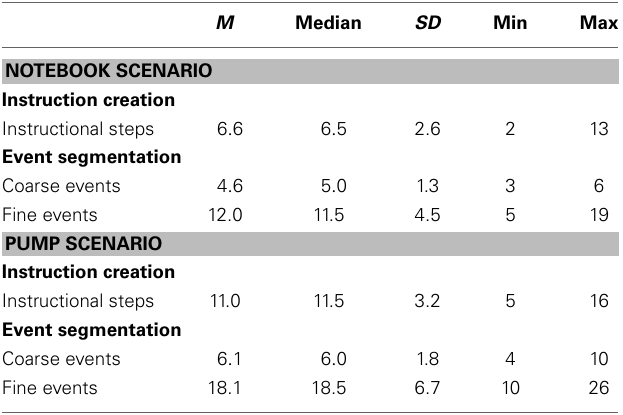
Table 2 | Consensus version for each scenario with steps being described during textual description by at least half ( N = 10) out of all participants ( N =